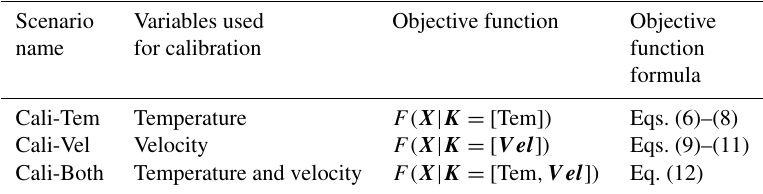
Table 3. Summary of objective function formulations for different calibration